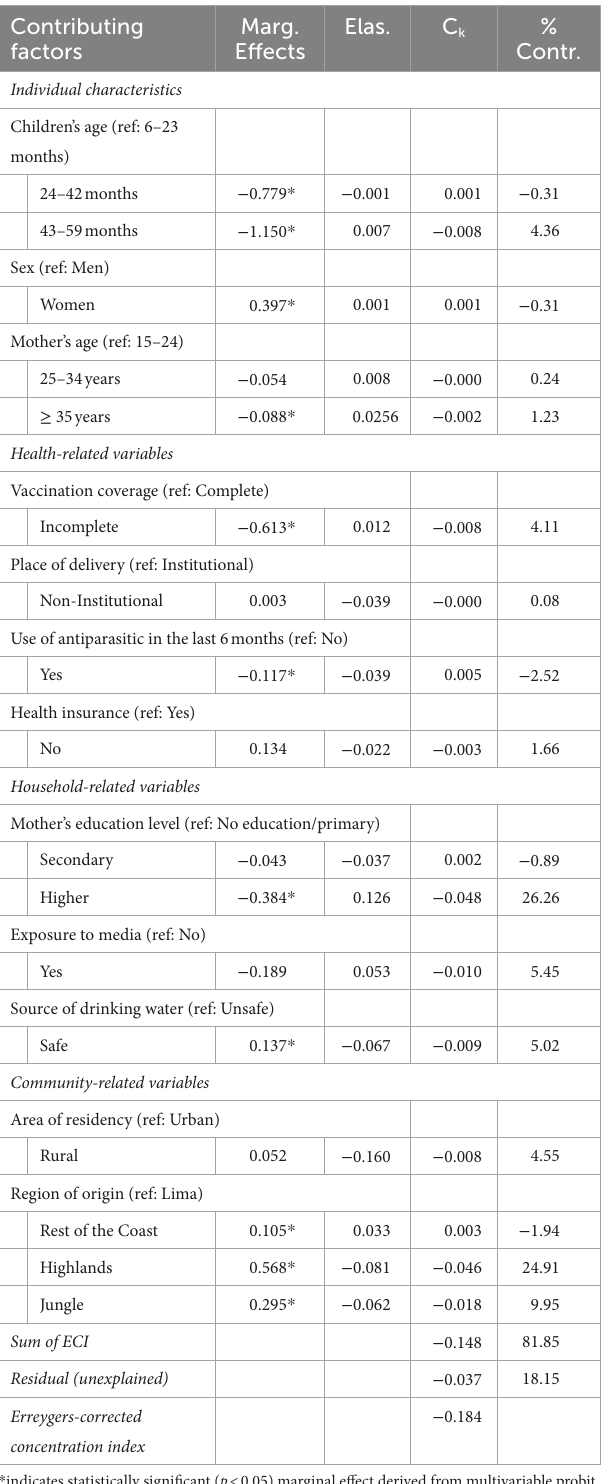
TABLE 2 Detailed decomposition of Erreygers normalized concentration